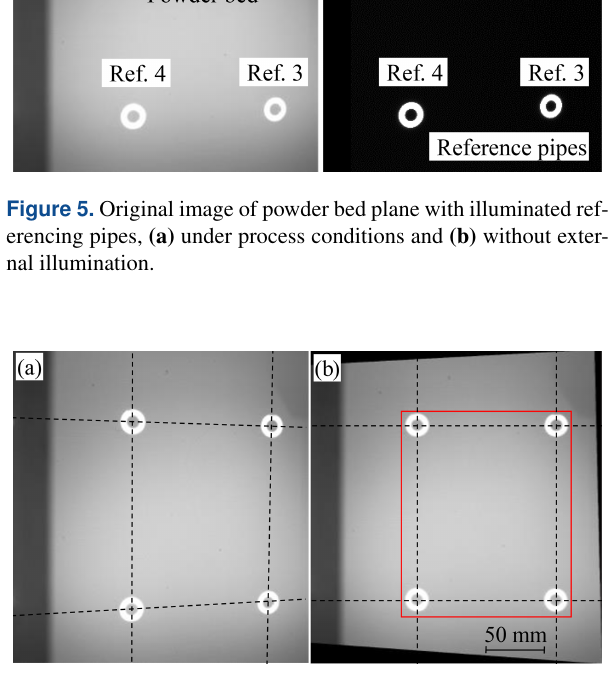
Figure 6. Correction of image deformations of the (a) original im- age to a (b) rectified and undistorted image with subsequent area delimitation of the ROI.